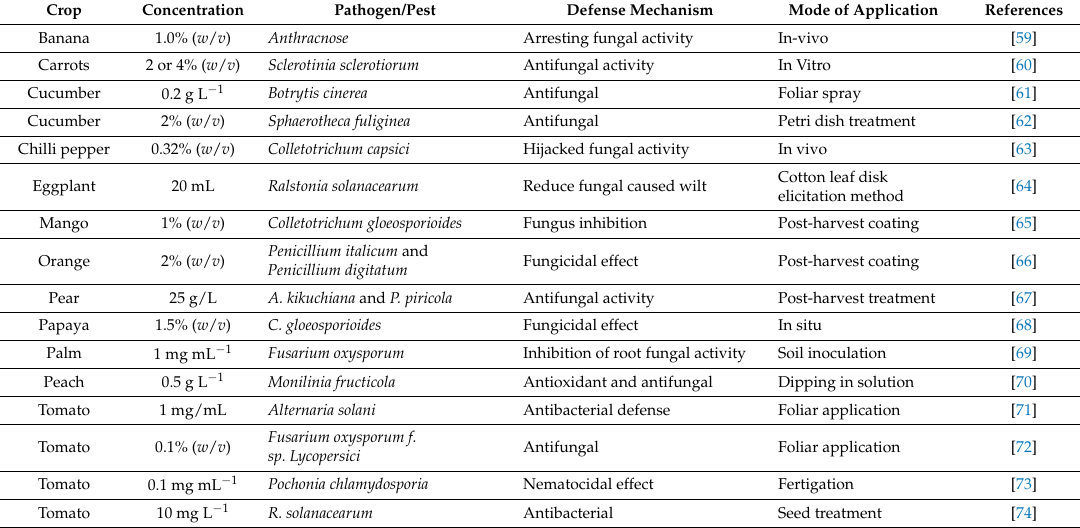
Table 2. Defense mechanisms induced by chitosan in horticultural